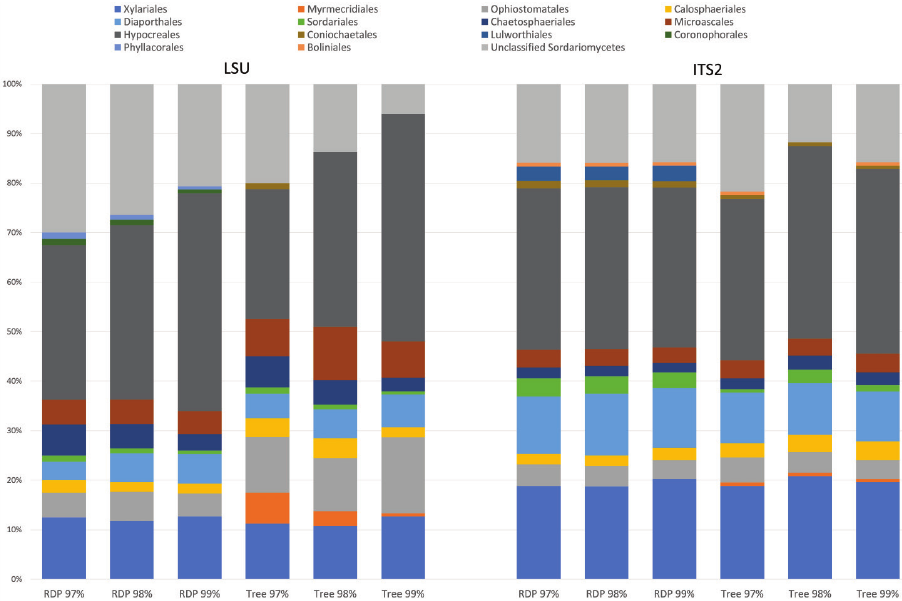
Figure 8. Proportion of OTUs assigned to each Order from metabarcoding with LSU (left panel) and ITS (right panel) markers based on the RDP classifier and the phylogenetic tree, under increasing threshold